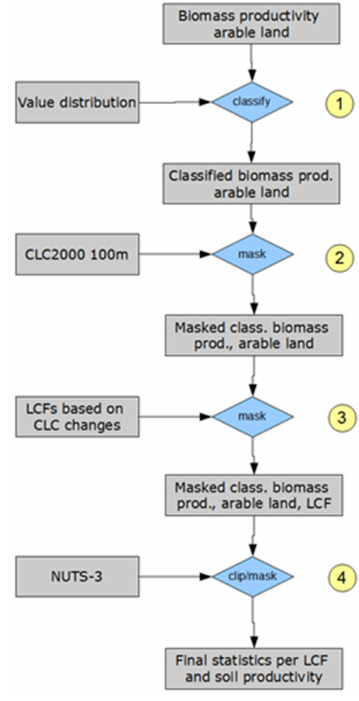
Figure 2. Schematic workflow of the